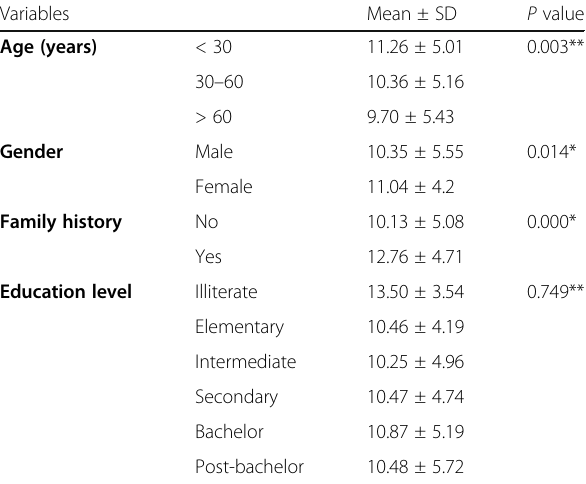
Table 4 Mean score knowledge by characteristic